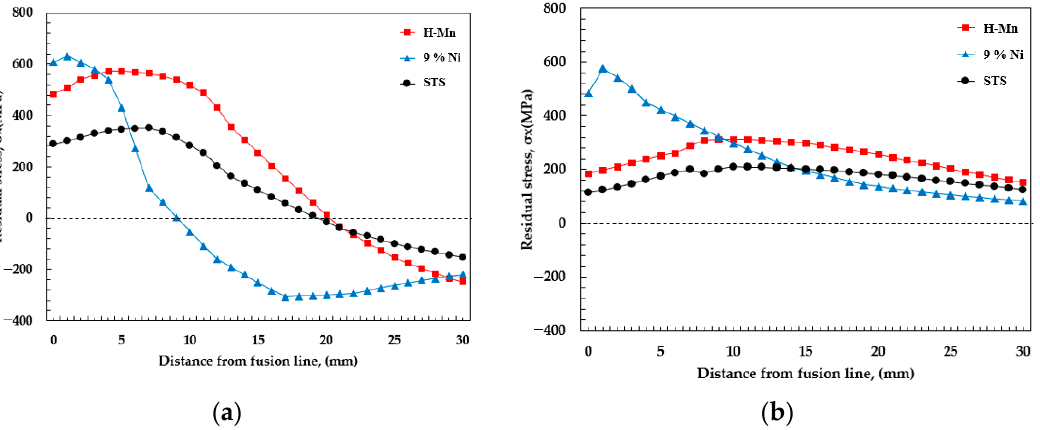
Figure 9. Welding residual stress distributions for the three types of materials: ( a ) weld line-direction stress, i.e., σ x , and ( b ) transverse-direction stress, i.e., σ y , obtained from the FE analysis.